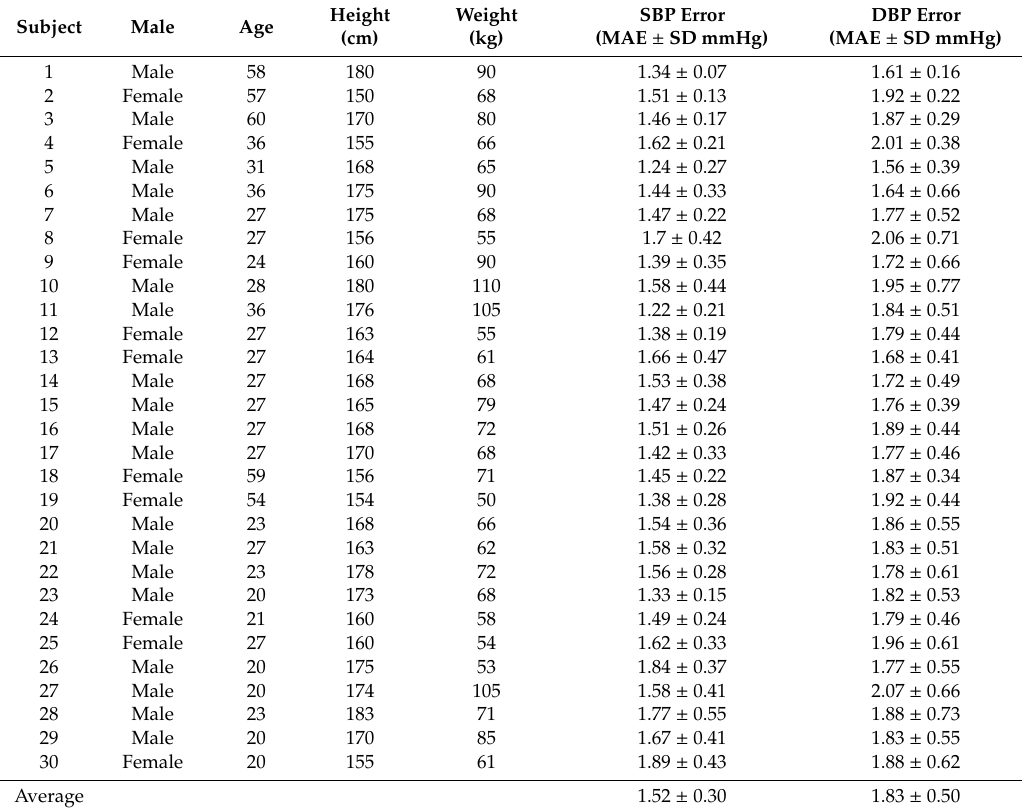
Table 1. Accuracy evaluation for our